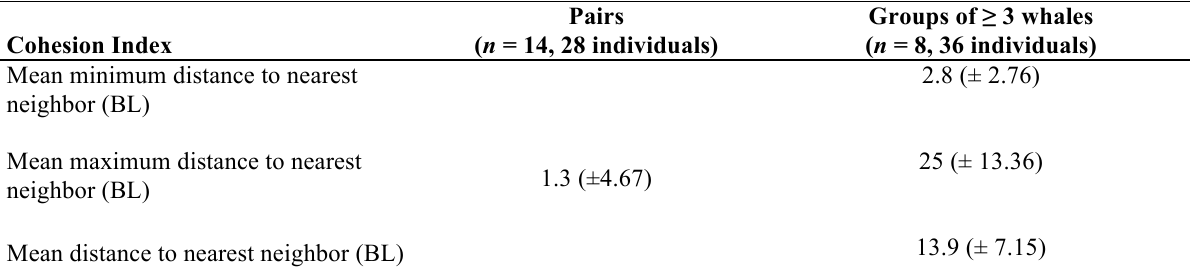
Mean and Standard Deviations of Minimum and Maximum Cohesion for Blue Whale Pairs (P) and Groups ≥ 3 Whales (G ≥ 3)